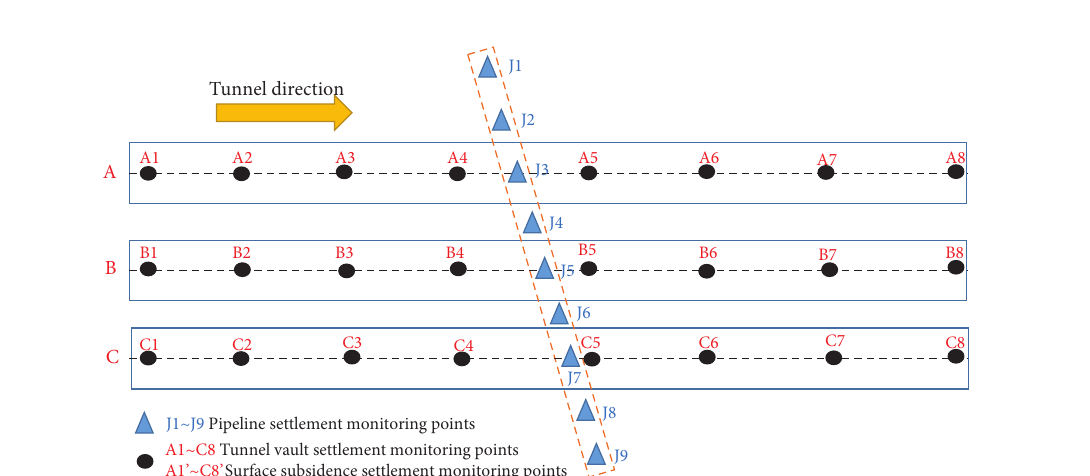
Figure 14: Monitoring point layout plan.